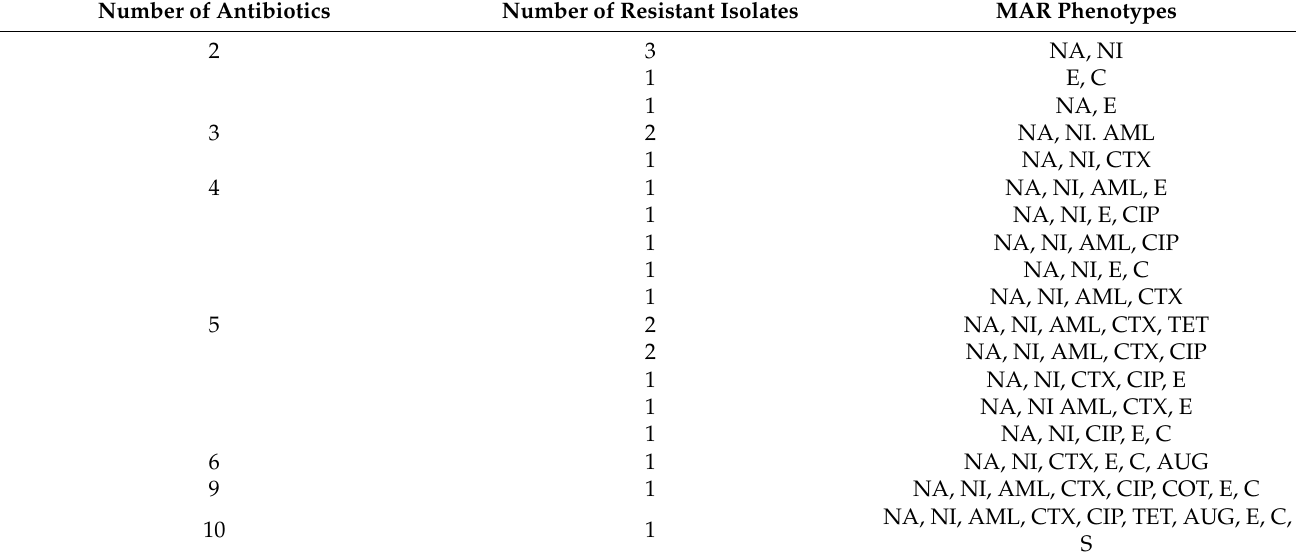
Table 2. Listeria isolates resistant to two or more